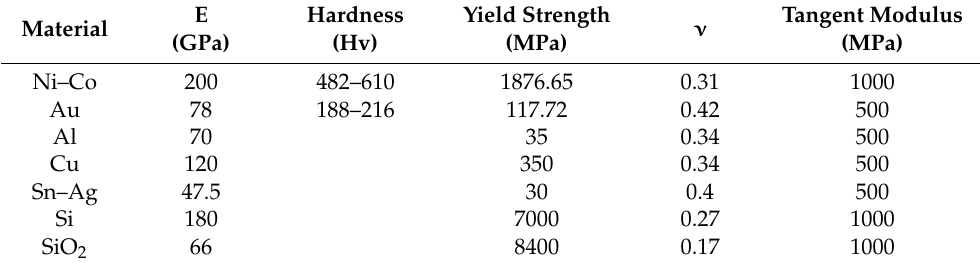
Table 2. Properties of materials used in the mechanical-behavior analyses.